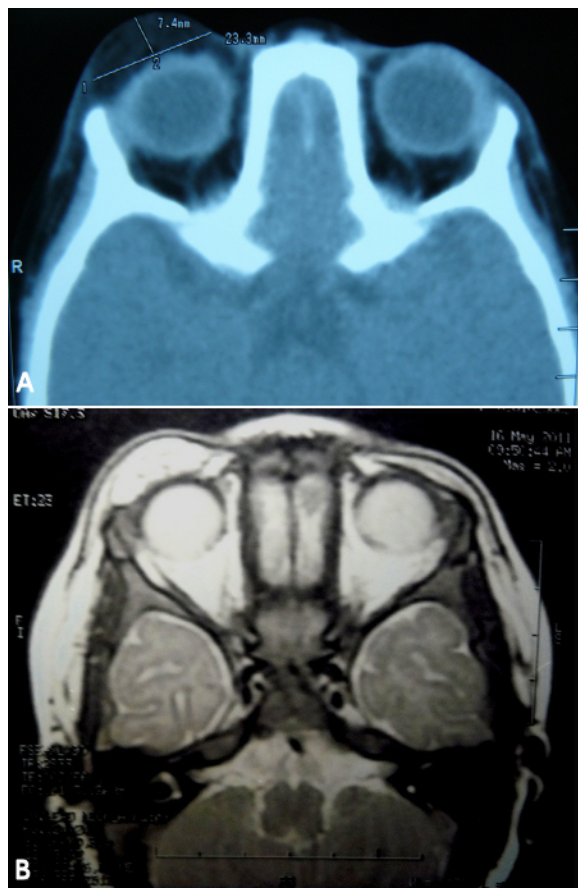
Figure 2: CT images show a 7.4×23.3 mm-sized low density mass in the upper eyelid of the right orbit (A). T2-weighted magnetic resonance imaging (MRI) presenting a high signal intensity (B).